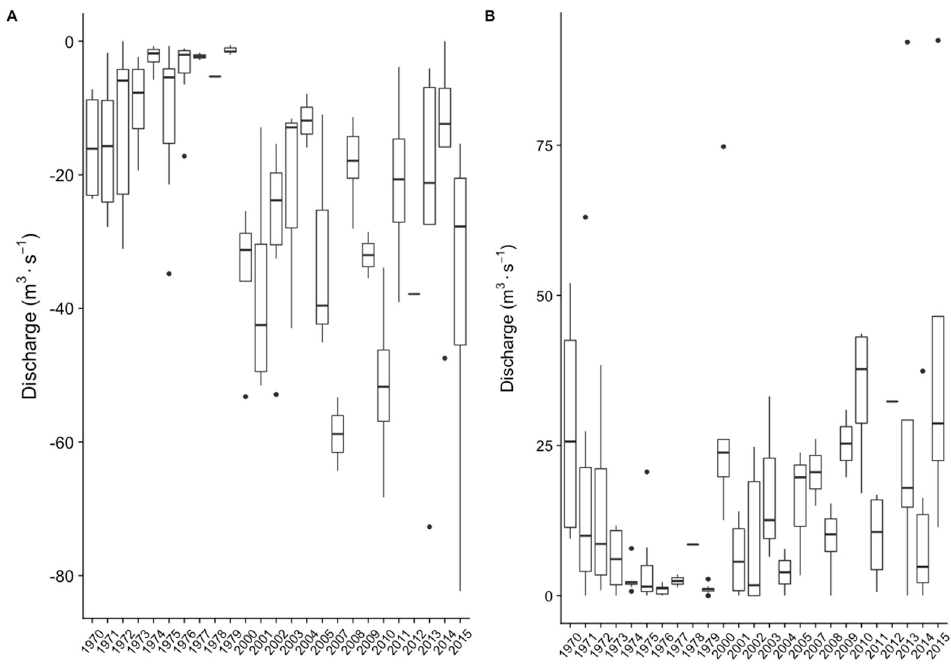
Figure 6. Drops (panel ( A )) and rises (panel ( B )) for the pre- and post-regulation periods.